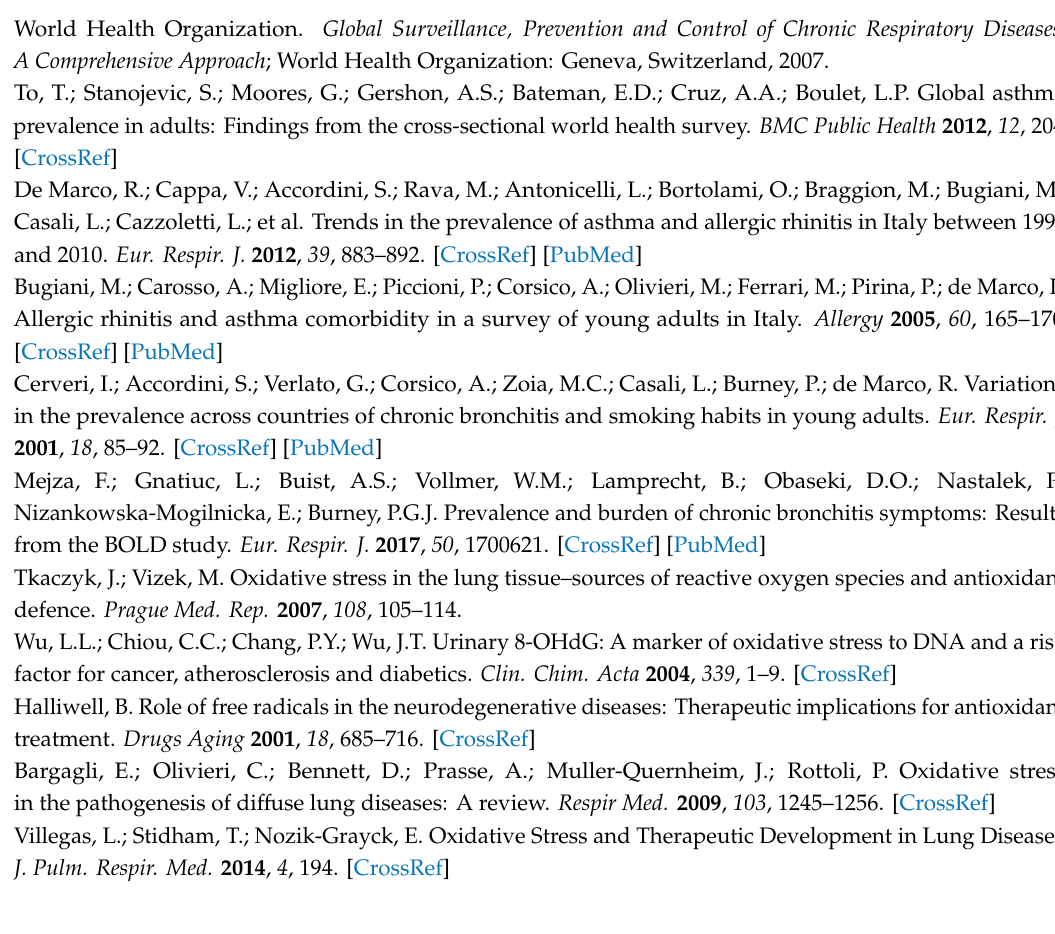
Table S1. Characteristics of the sample (current and past asthma cases vs. controls). Non-hierarchical classification. Table S2. Characteristics of the sample (chronic bronchitis cases vs. controls). Non-hierarchical